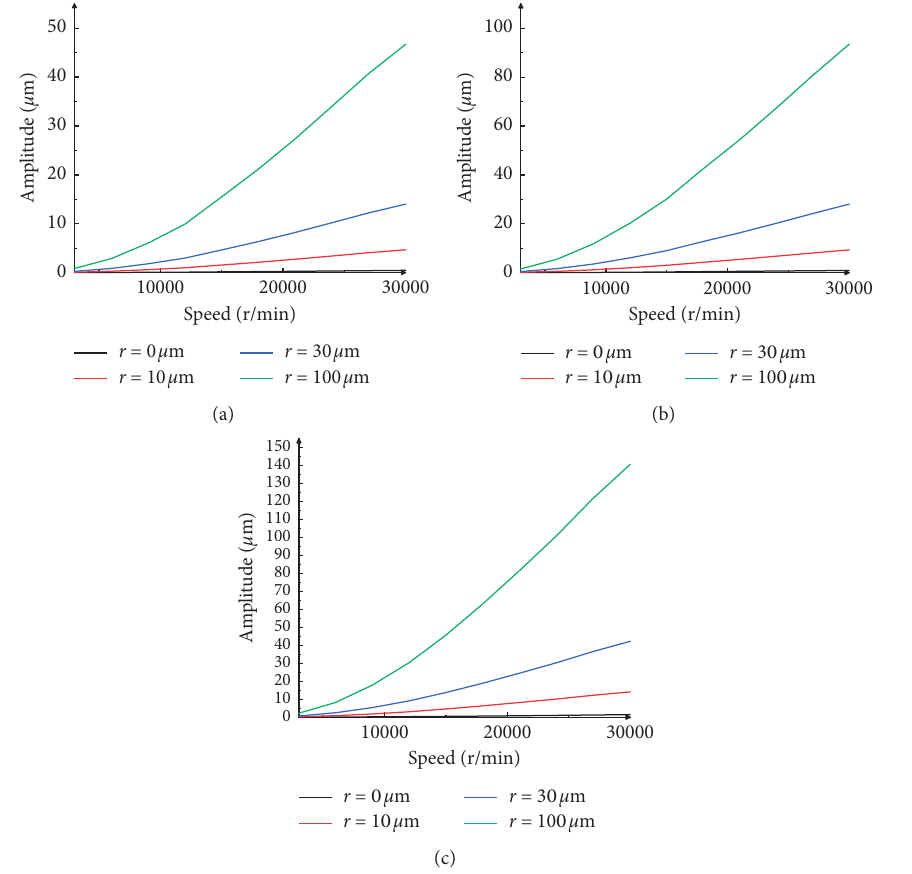
Figure 11: Effect of different static eccentricity on vibration with mass eccentricity of (a) 10 µ m, (b) 20 µ m, and (c) 30 µ